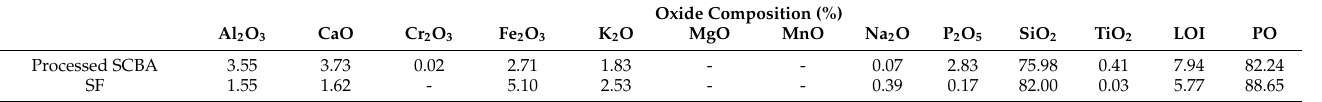
Table 3. Oxide composition of SCBA and